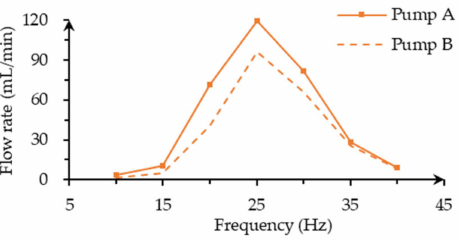
Figure 11. Flow rate comparison of the same type of pump.